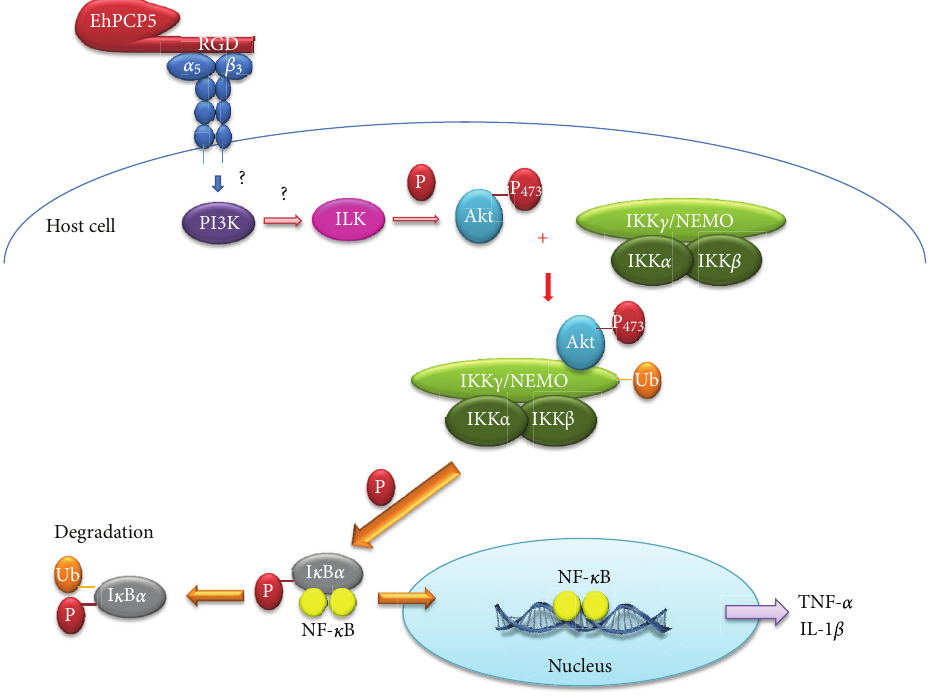
Figure 6: EhPCP5 stimulates NF 𝜅 B-mediated proinflammatory responses. Attached to E. histolytica surface or secreted, EhPCP5 binds to 𝛼 (V) 𝛽 (3) integrin through the RGD motif and triggers PI3K-mediated ILK activation. ILK phosphorylates Akt-473, which binds and induces the ubiquitination of NEMO. This activates the IKK 𝛼 -IKK 𝛽 complex that phosphorylate I 𝜅 B 𝛼 . This phosphorylation event signals I 𝜅 B 𝛼 ubiquitin-mediated degradation and, thereby, the release of NF- 𝜅 B into the nucleus, where it activates proinflammatory gene expression.